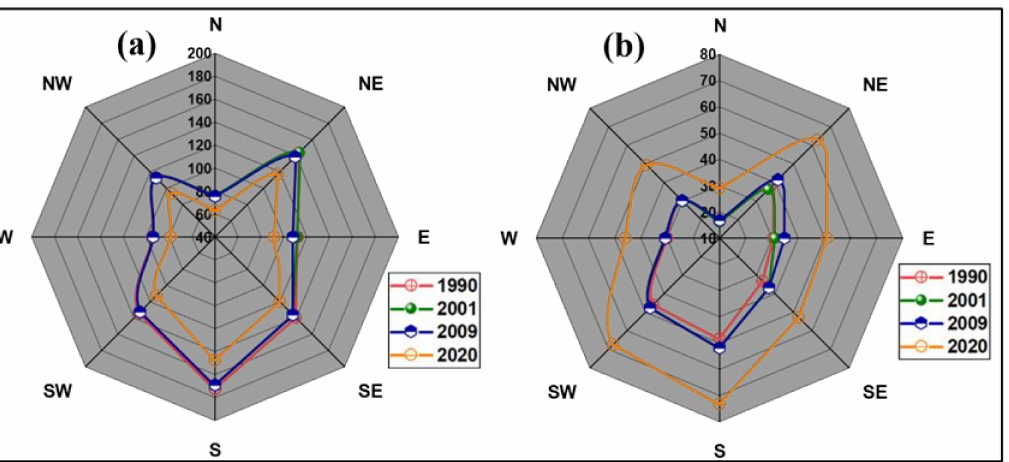
Figure 14. Debris and ice distribution on slope aspects (km 2 ); ( a ) area covered by ice and ( b ) area covered by debris at different slope aspects for the years 1990, 2001, 2009, and